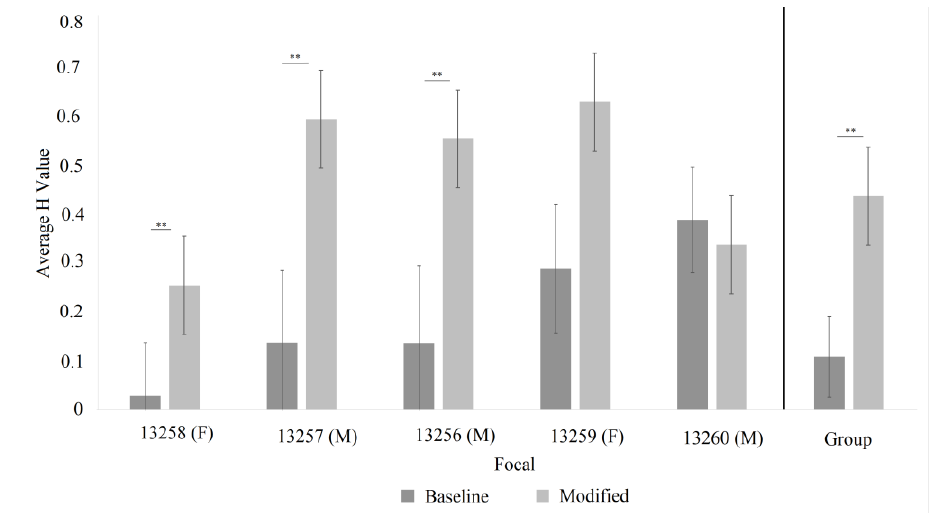
Figure 3 . Average behavioral diversity (H) values (mean + SE) for Madagascar giant hognose snakes comparing baseline and modified habitats for each individual ( N = 23) and the group ( N = 4, excluding 13260). ** p < .05, M = male, F = female.